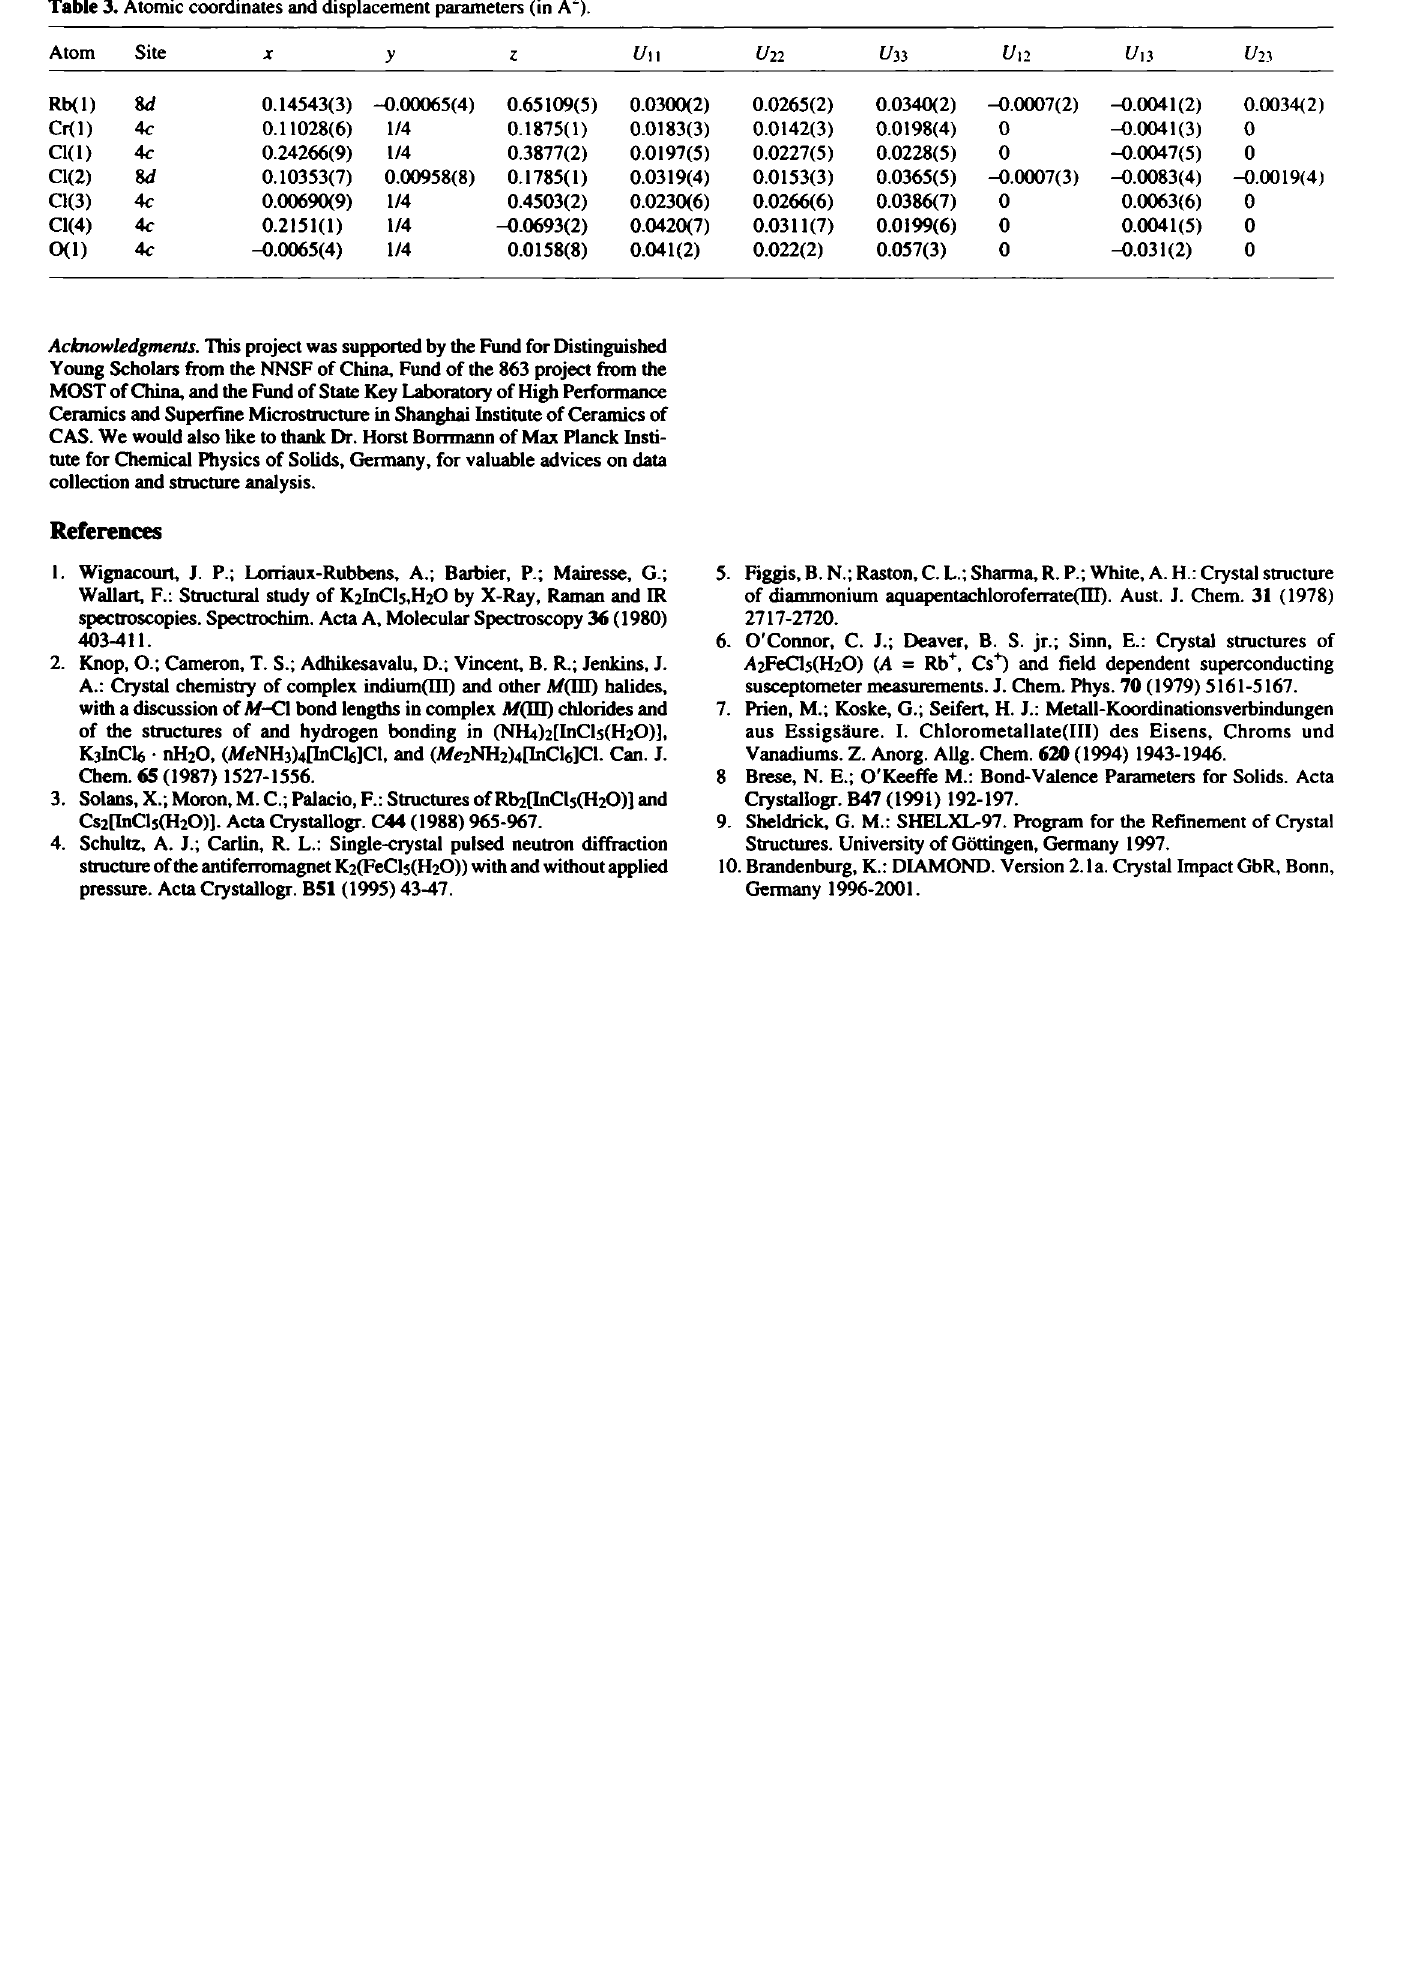
Table 3. Atomic coordinates and displacement parameters (in À 2